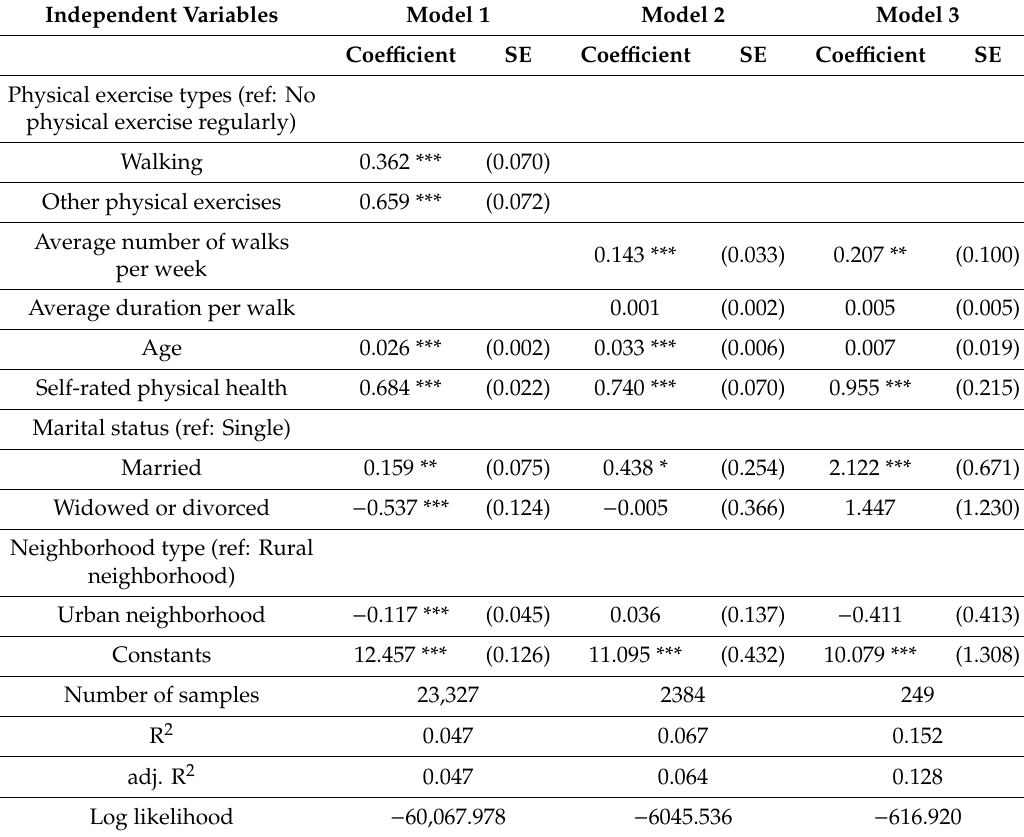
Table 2. Regression analysis results for the relationship between emotional health and